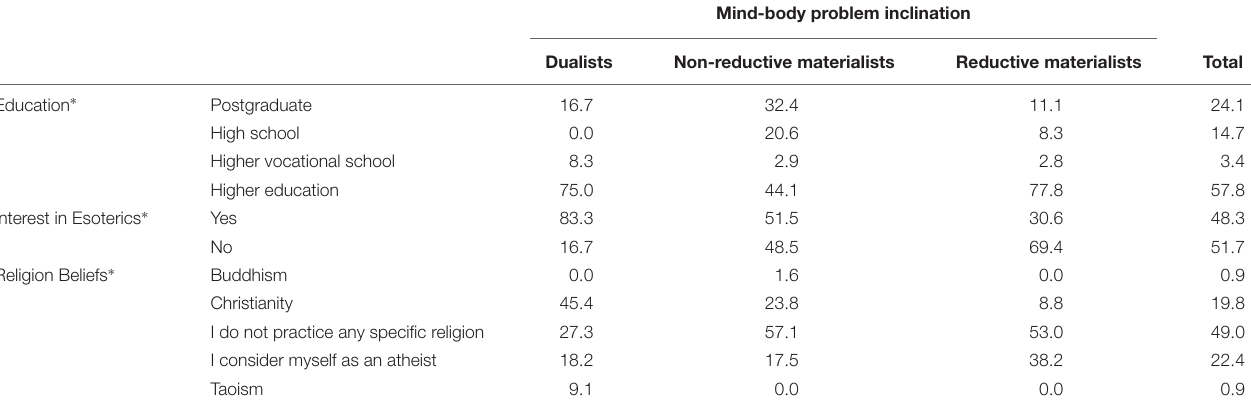
TABLE 1 | Demographic data for each category of mind-body problem inclination.